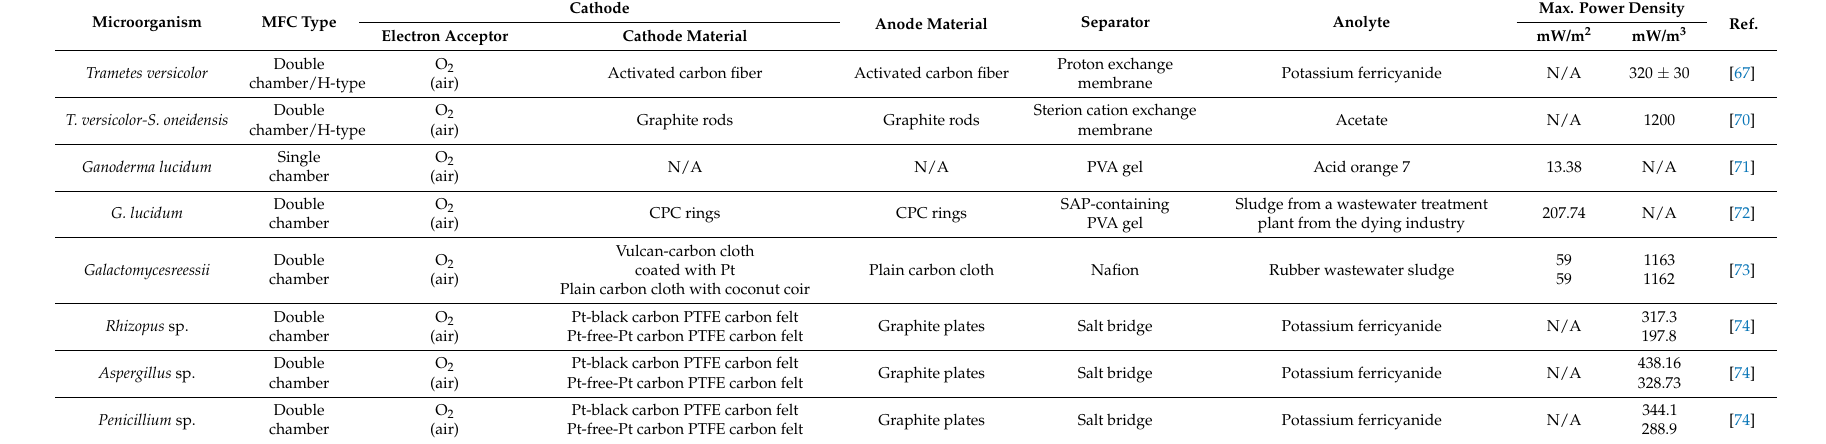
Table 2. MFCs using fungi as cathode